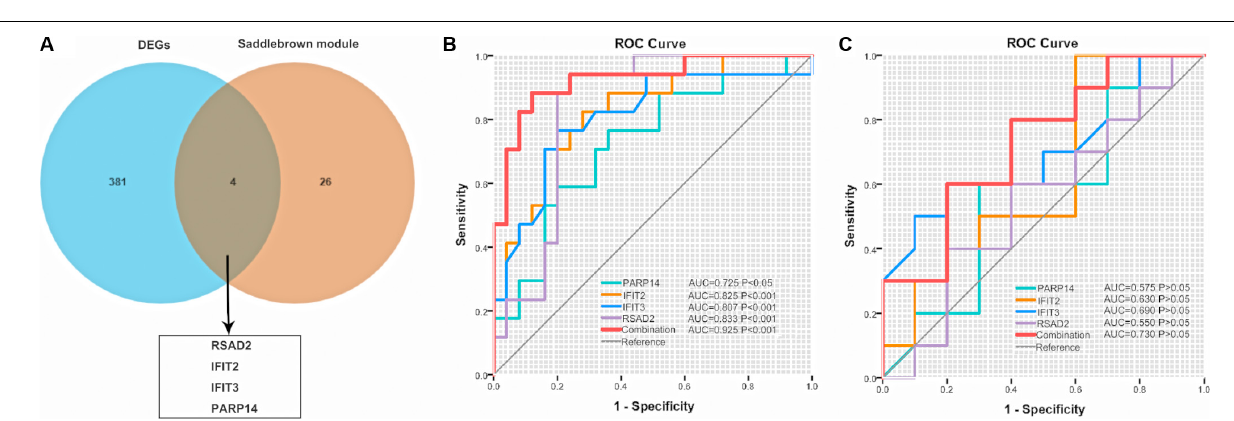
FIGURE 6 | Venn diagram and ROC. (A) Common genes between DEGs in GSE19617 and the saddlebrown module. (B) ROC of the four genes for the diagnosis of SSc and SSc-PAH in the GSE19617 or the validation cohort (C) , respectively. ROC, receiver operating characteristic; SSc, systemic sclerosis; PAH, pulmonary arterial hypertension; DEGs, differently expressed genes; AUC, area under the